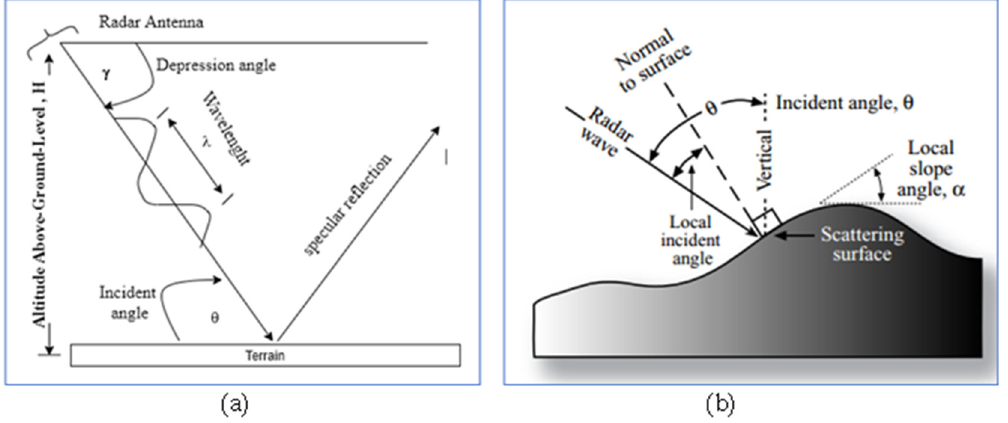
Figure 2. Targets on the surface of the earth with ( a ) flat terrain and ( b ) varied terrain that are exposed to radar wave radiation [44].